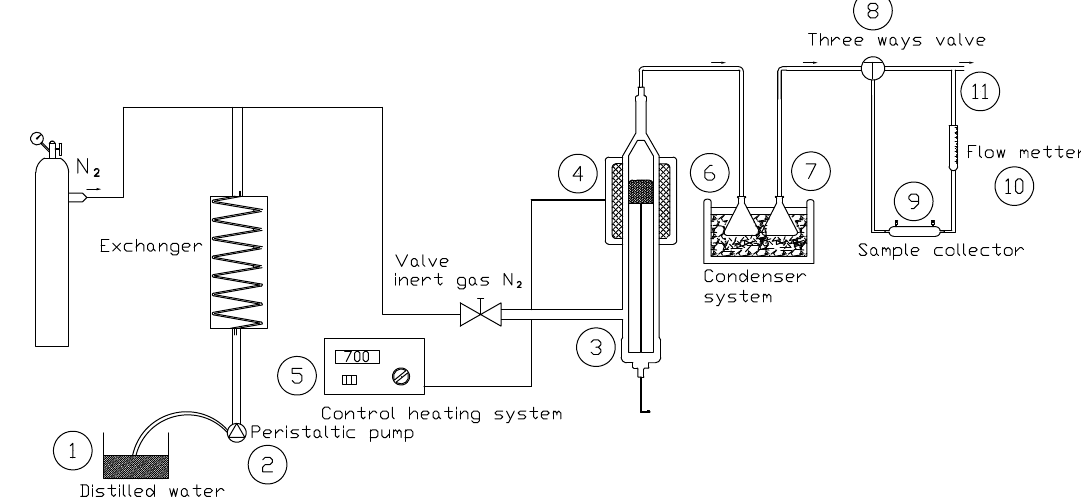
Figure 1. Experimental set-up. Elements: 1-Water container; 2-Bomb; 3-Reactor; 4-Furnace; 5-Temperature controller; 6-Cooling bath; 7-Condensers; 8-Three way valve; 9-Gas sample collecting system; 10-Flow meter; 11-Gas outlet (to